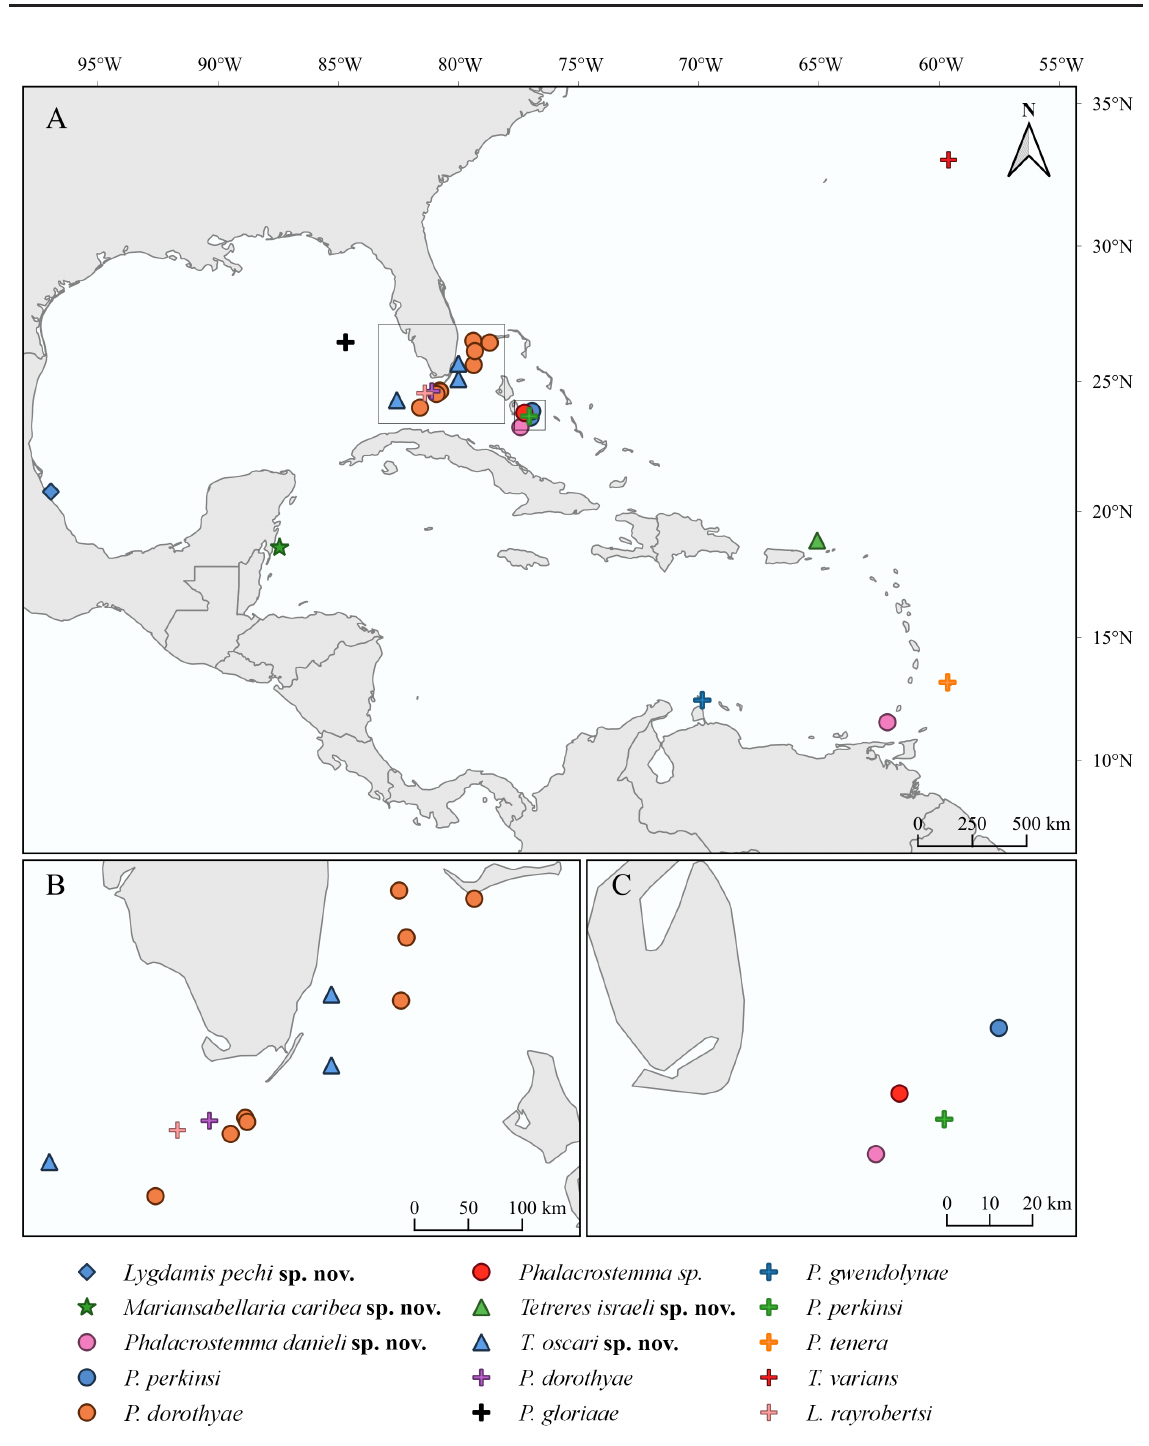
Fig. 22. Localities for studied specimens. A . Caribbean Sea and the Gulf of Mexico. B . South Florida. C . Southeastern Bahamas. The crosses indicate type localities of species previously recorded in the tropical Western